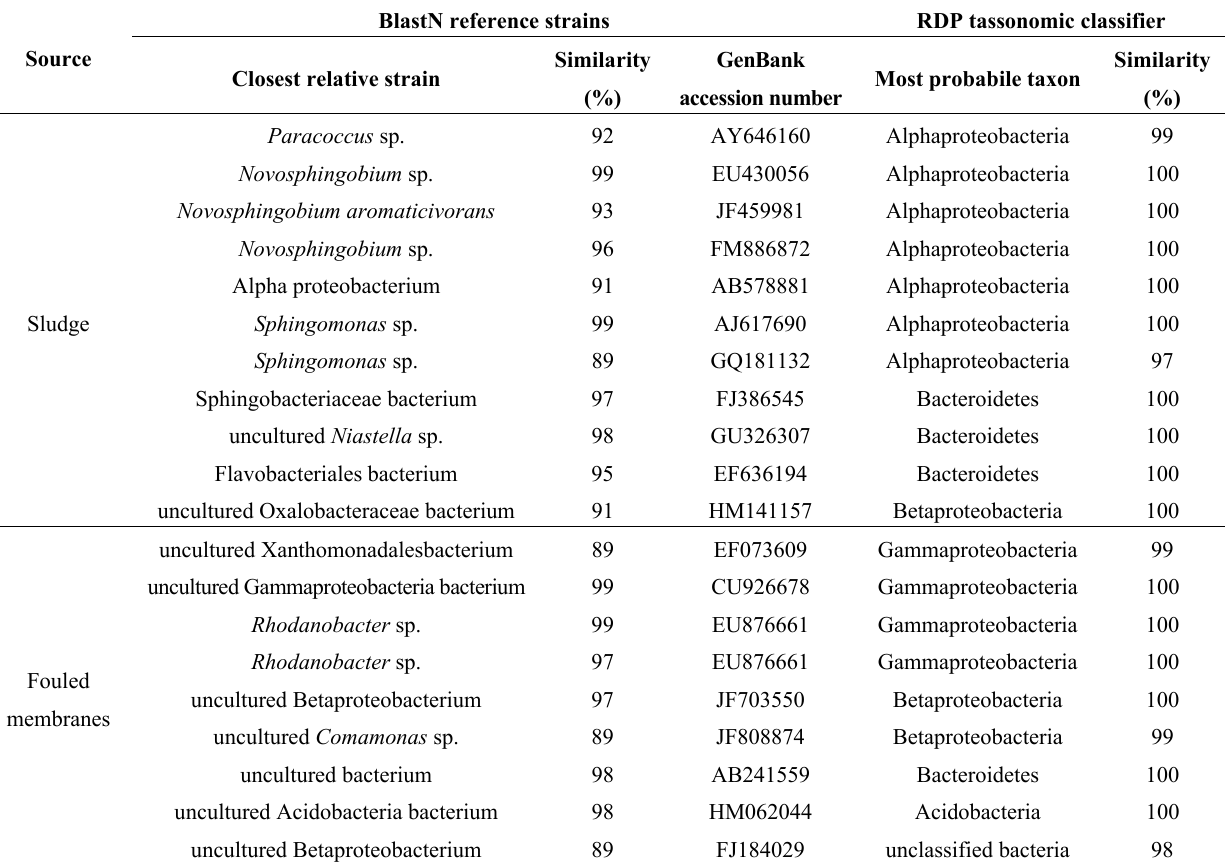
Table 1. Identification of partial 16S gene sequences from excised bands observed in denaturing gradient gel electrophoresis (DGGE) profiles.